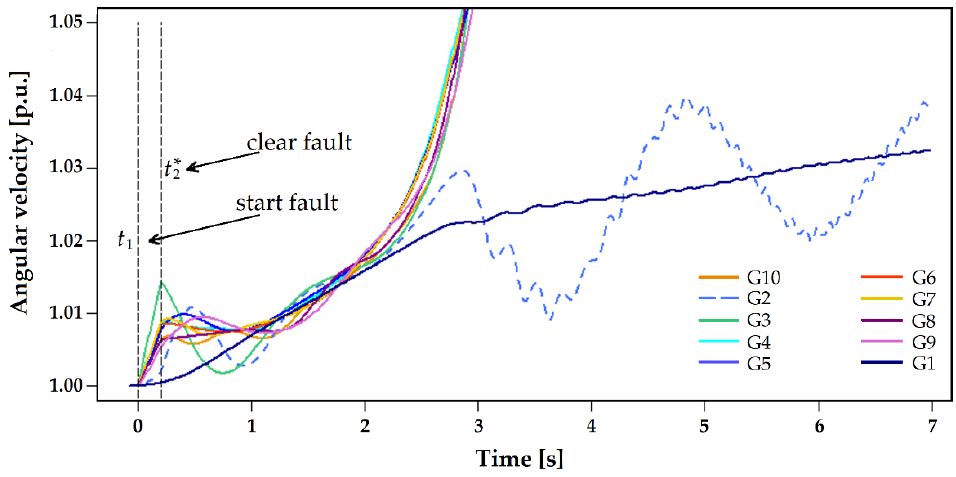
Figure 10. Rotor speed of the generator in an unstable case.